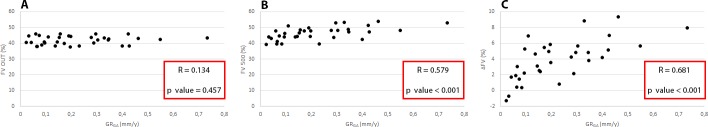
Graphic representation of the correlations explored in the study.Scatterplots showing the yearly geographic atrophy growth rate (yGR) after square root transformation and the percentage of flow voids outside the atrophy (FVOUT) (A) in the para-atrophy region (FV500) (B), and the difference between para- and peri-atrophy regions (ΔFV) (C). R: Pearson’s correlation coefficient; p value: two tailed p-value.